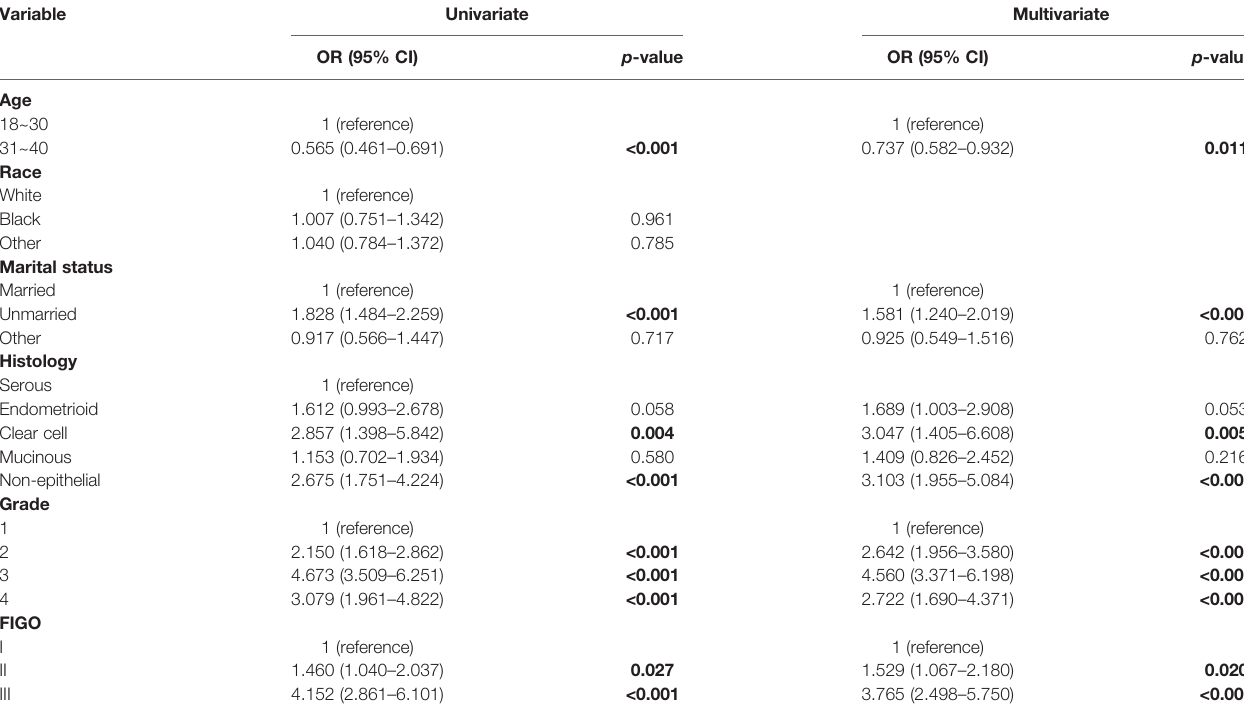
TABLE 2 | Univariate and multivariate logistic regression for associations between patient characteristics and